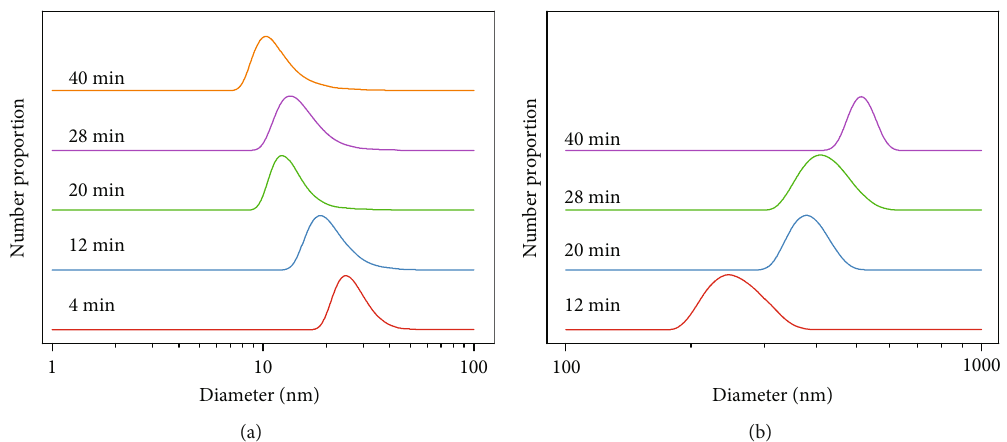
Figure 12: Evolution of particle size distribution in (a) di ff erential microemulsion polymerization and (b) soap-free emulsion